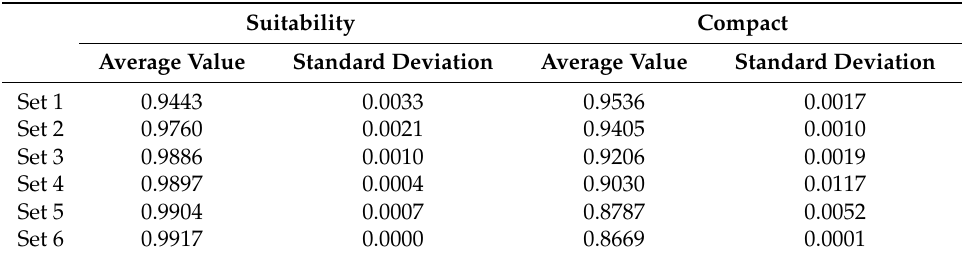
Figure 11. Distribution of six sets of solutions in Pareto fronts of Pareto-ABC algorithms based on 8 experiment results. Table 5. Statistics of the six sets of solutions shown in Figure 11.